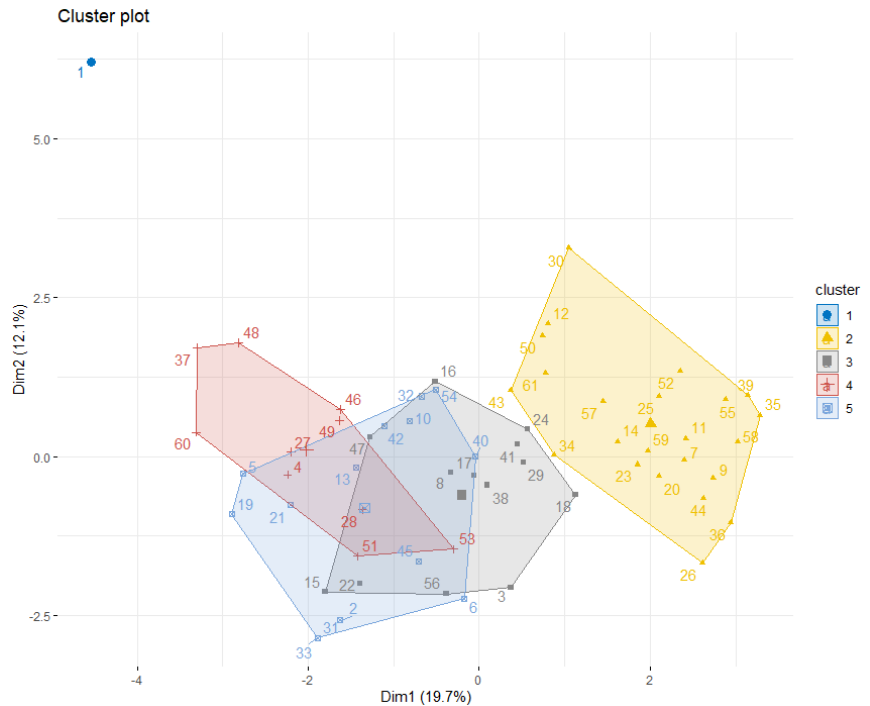
Figure 3. K-Means. Partitioning around medoids.